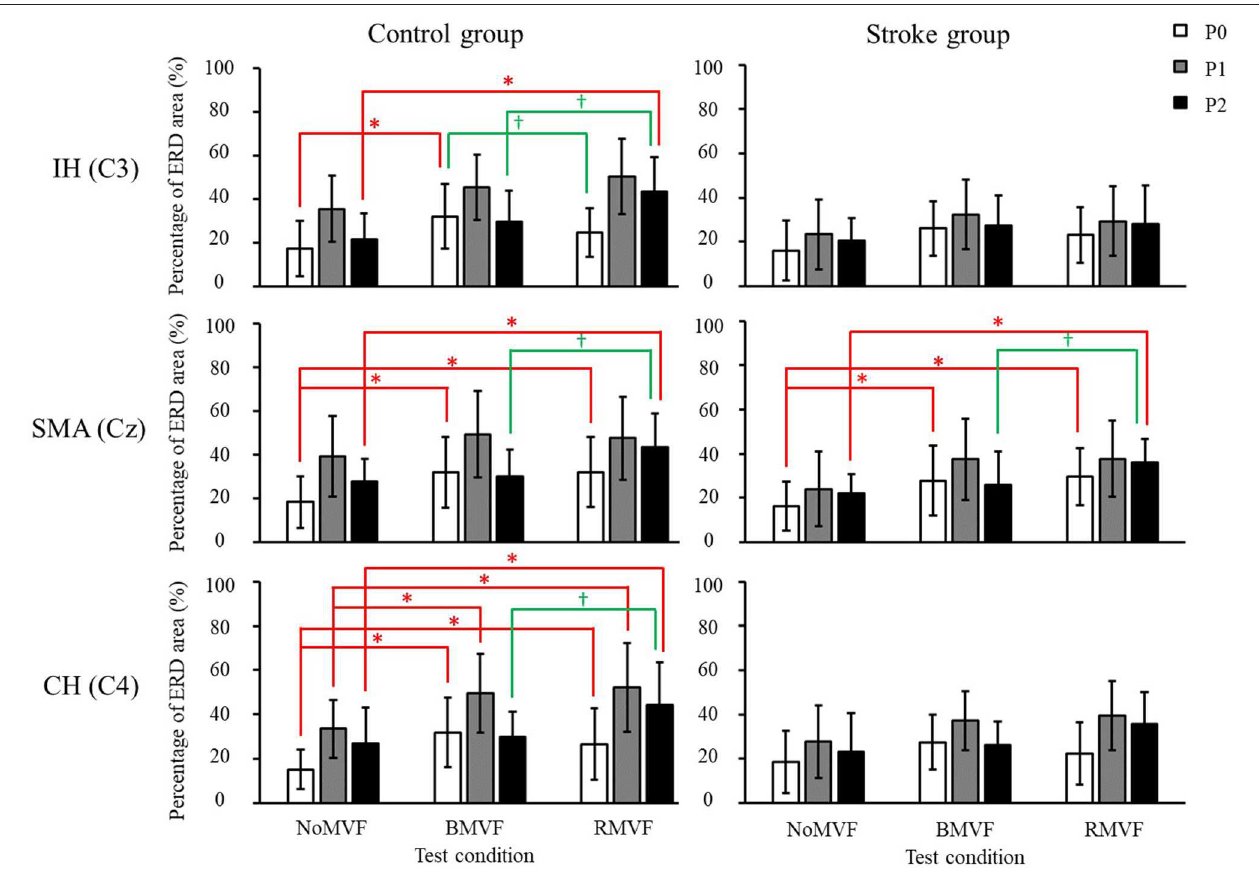
FIGURE 4 | Mu band event-related desynchronization (ERD) areas (%) of the control and stroke group ( n = 16 each) with error bars (standard deviations) for the three test conditions (NoMVF, BMVF, and delayed RMVF) for the IH (C3), SMA (Cz), and CH (C4) brain areas, respectively. The ERD areas (%) are shown as P0: white, P1: gray, and P2: black; a time-course change in cortical activation can be observed. * , † ERD areas (%) of this test condition are significantly higher than the areas of the previous test condition for the same brain